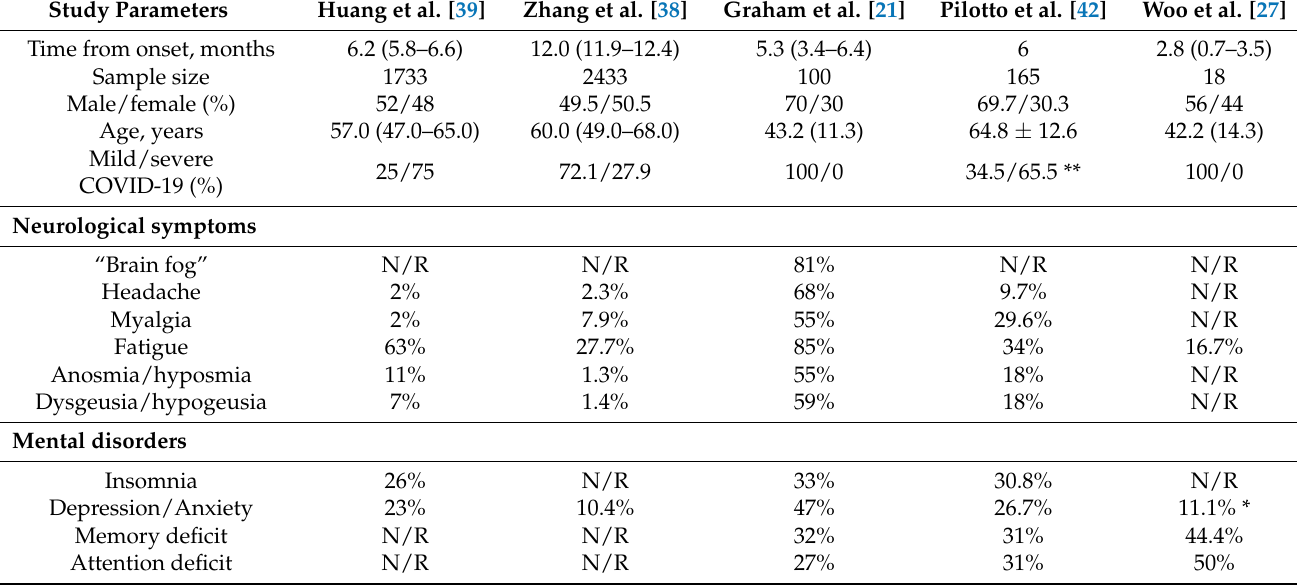
Table 1. Neurological manifestations of